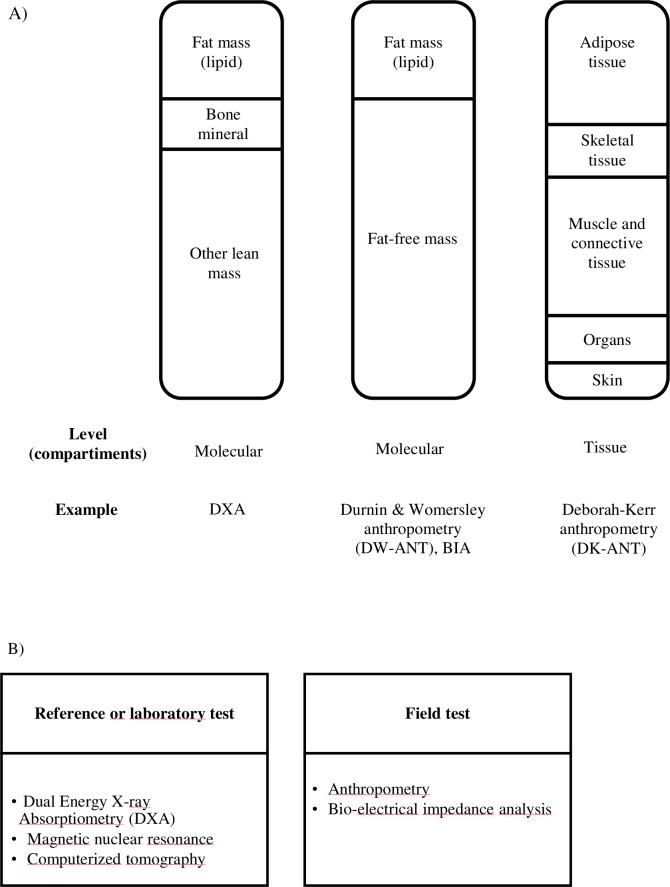
Types of levels of human body composition.A) According to level of analysis B) According to degree of accuracy of referent or field tests.